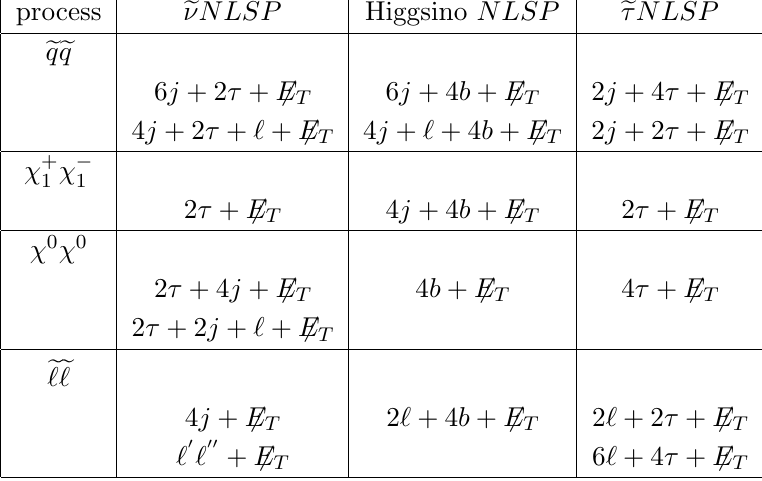
Table 6 . Most likely phenomenological signatures for various SUSY pair productions modes in three benchmark scenarios with sneutrino, Higgsino, and stau